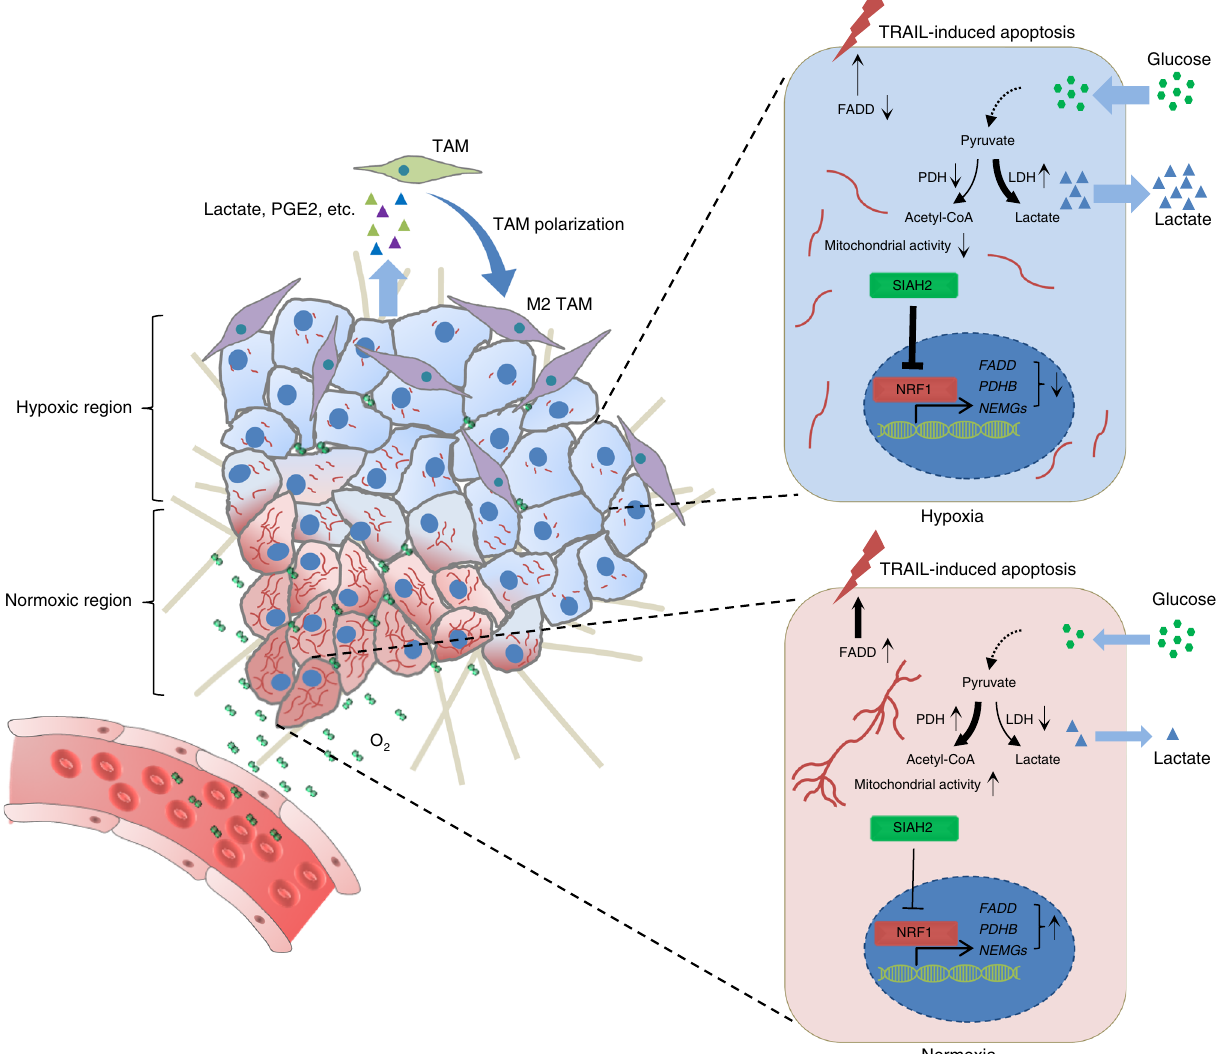
Fig. 9 A proposed model of the SIAH2-NRF1 axis in regulating the formation of pro-tumor